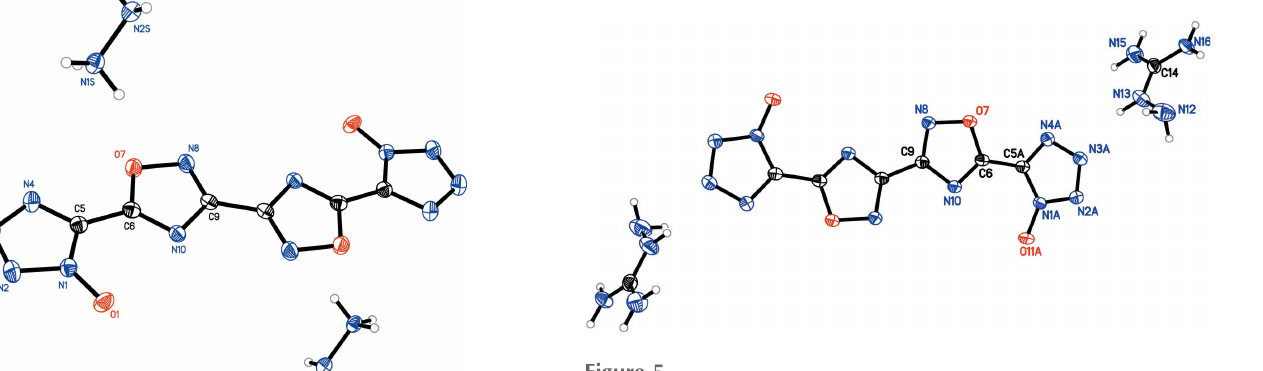
Figure 1 Molecular structure of 1 , showing the atom-labeling scheme. Displace- ment ellipsoids are drawn at the 50% probability level.